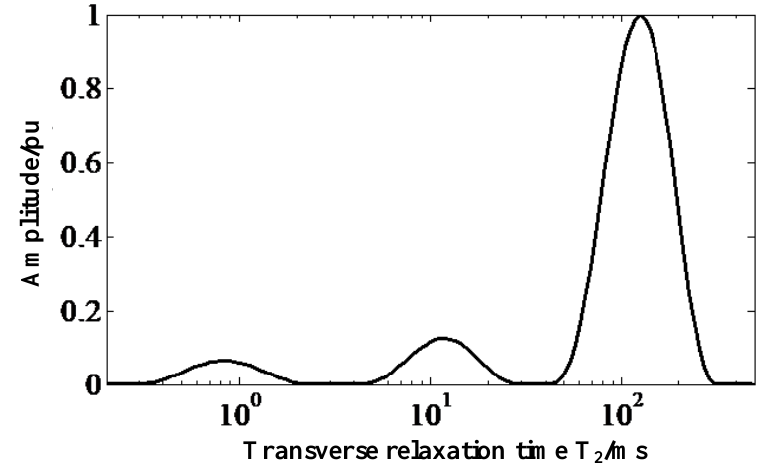
Figure 13. T 2 distribution by Inverse Laplace Transform.